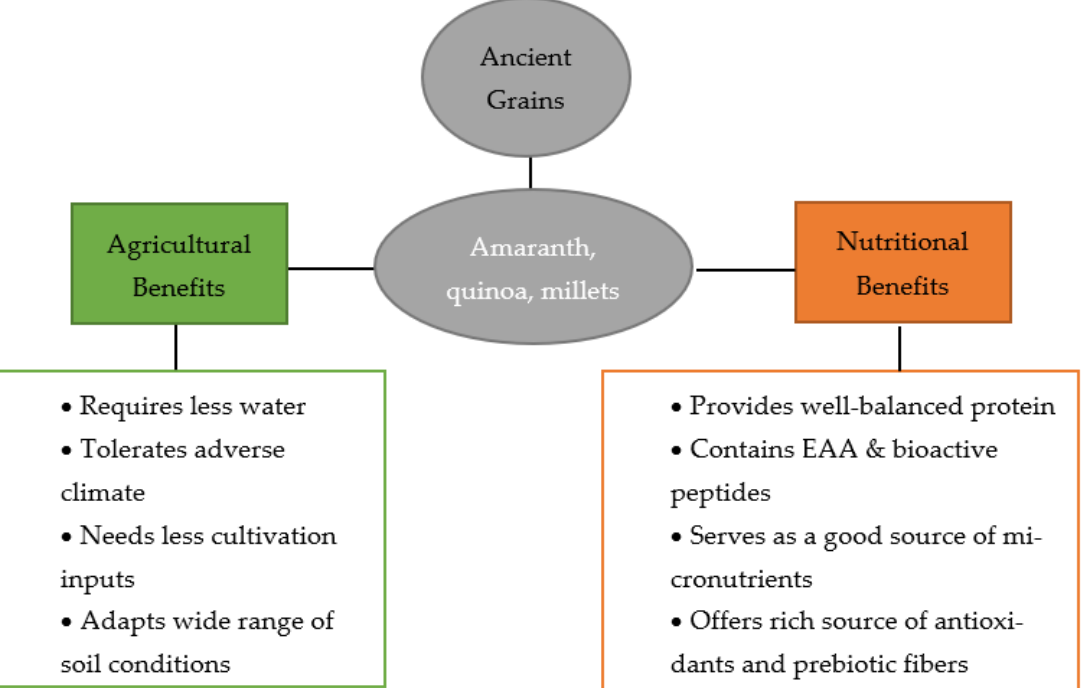
Figure 1. Agricultural and nutritional benefits of amaranth, quinoa, and millets. Amaranth and quinoa are native to the Andean region, belonging to the Amaranthaceae family. Both crops share similarities in their historical background and botanical identity. Amaranth and quinoa seeds have been consumed in Central and South America for over 5000 years and were an essential component of the diet of ancient cultures such as the Aztec, Mayan, and Incan civilizations [8,9]. Quinoa was referred as the ‘mother grain’ because of its exceptional nutritional value [10], and it was regarded as a gift from their gods by the Inca people. Although they were a staple food along with maize and potatoes, their production and consumption were suppressed after the Spanish conquest, and thereafter their cultivation was limited to a much smaller scale